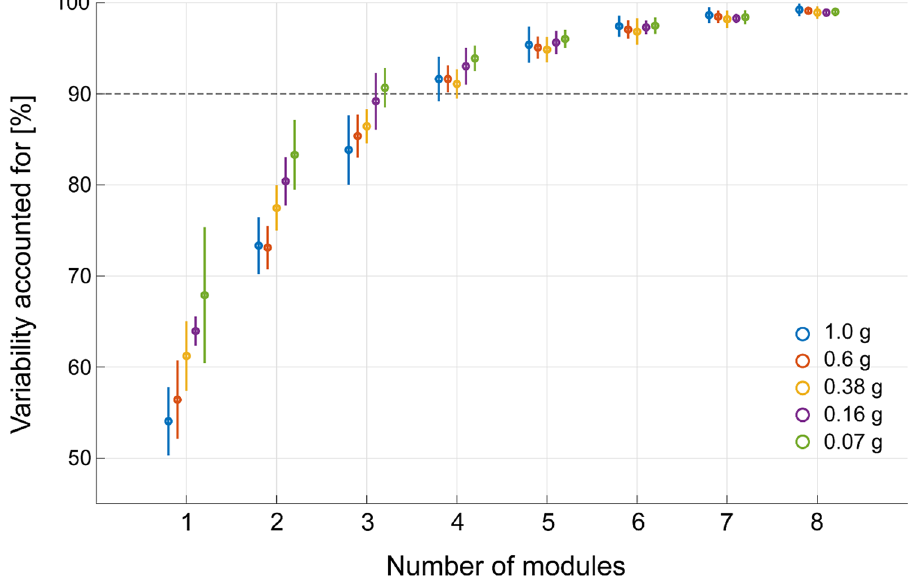
Figure 4. Goodness of fit of the EMG data reconstruction. The variability of the original EMG data matrix accounted for by 1–8 modules is shown. The circles and lines for the individual gravity levels are distinguished by colour. Each data point and bar are an average ± standard deviation across participants at a speed corresponding to Fr ~